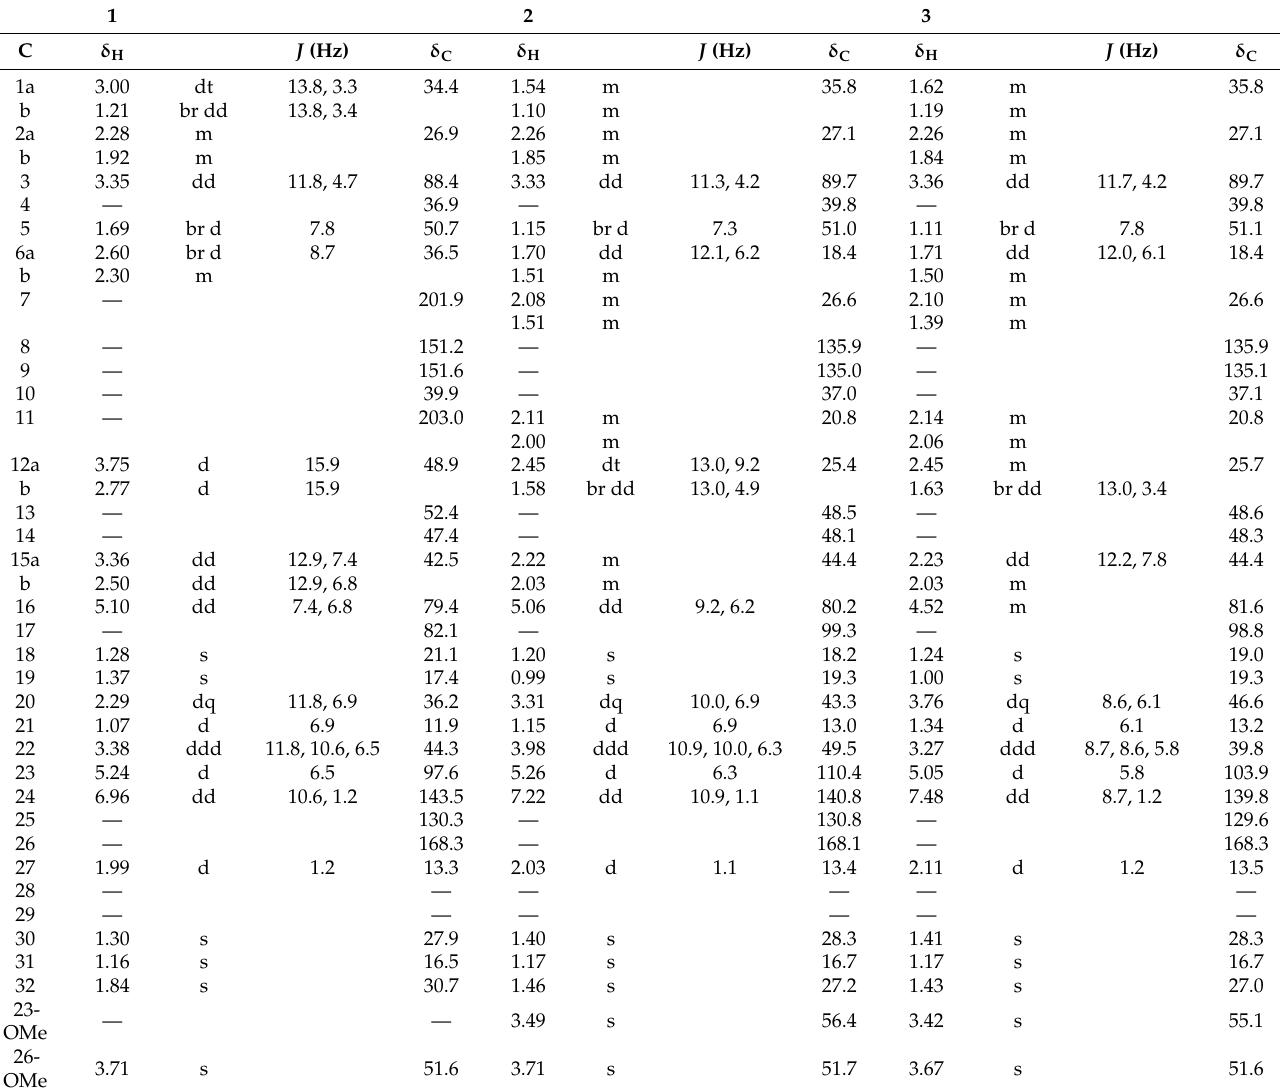
Table 1. 1 H and 13 C NMR (500 and 125 MHz, C 5 D 5 N) spectroscopic assignments of the aglycone moieties of 1 – 3 .